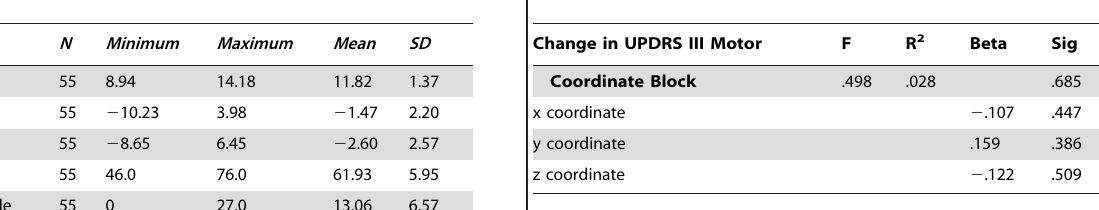
Table 3. Summary of Active Contact Data in STN Patients.